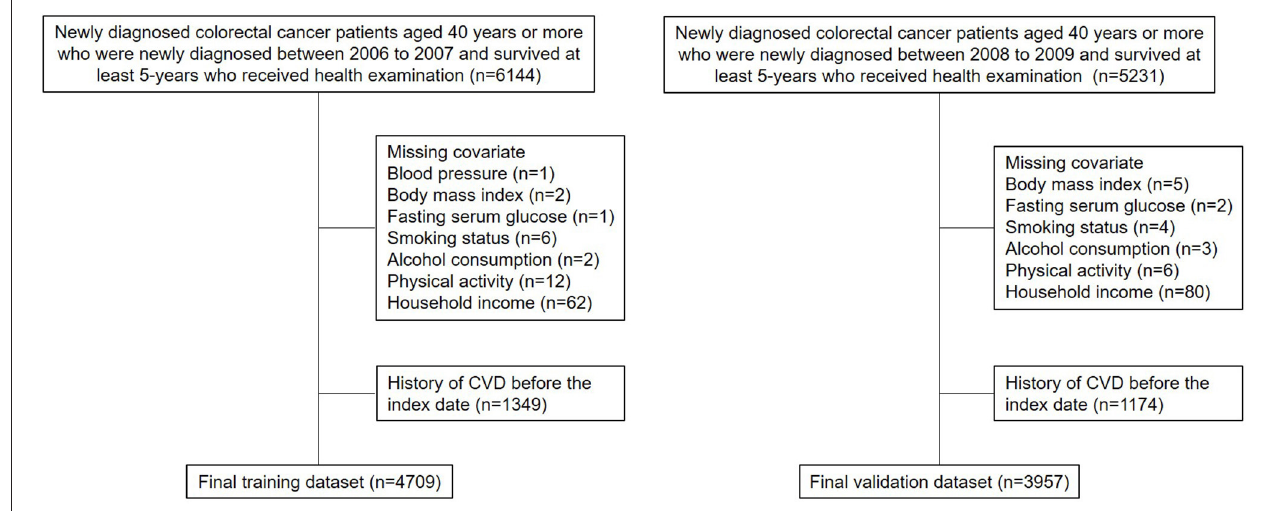
FIGURE 1 | Participant inclusion